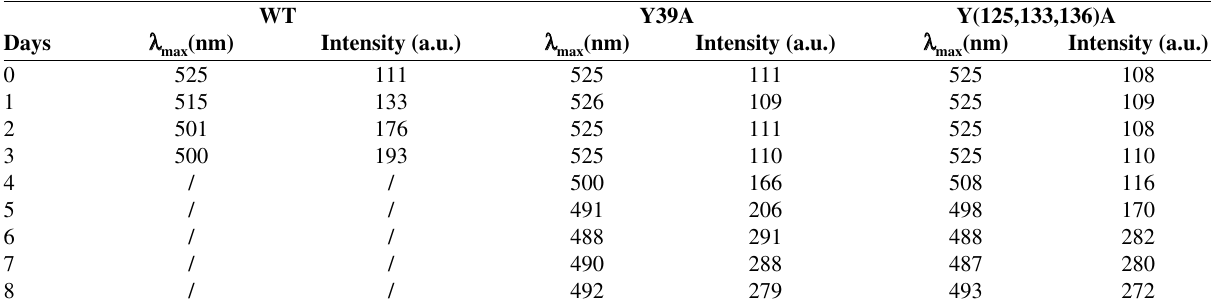
Table 1. The ANS binding profile of WT α -synuclein and its Y39A and Y(125,133,136)A mutants incubated at 37 °C and pH 7.0 for the period of 8 days. The results are an average of three measurements (SD was below 5 %). The fluorescence intensity maximum, λ of ANS fluorescence in the absence of proteins were 525 nm and 110 a.u., respectively. WT